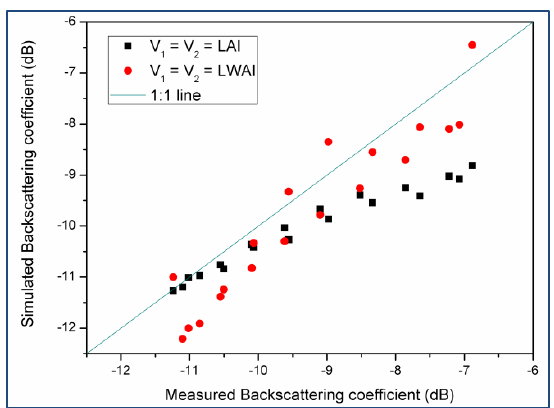
Figure 4.Comparison between observed and estimated values of LAI by modified